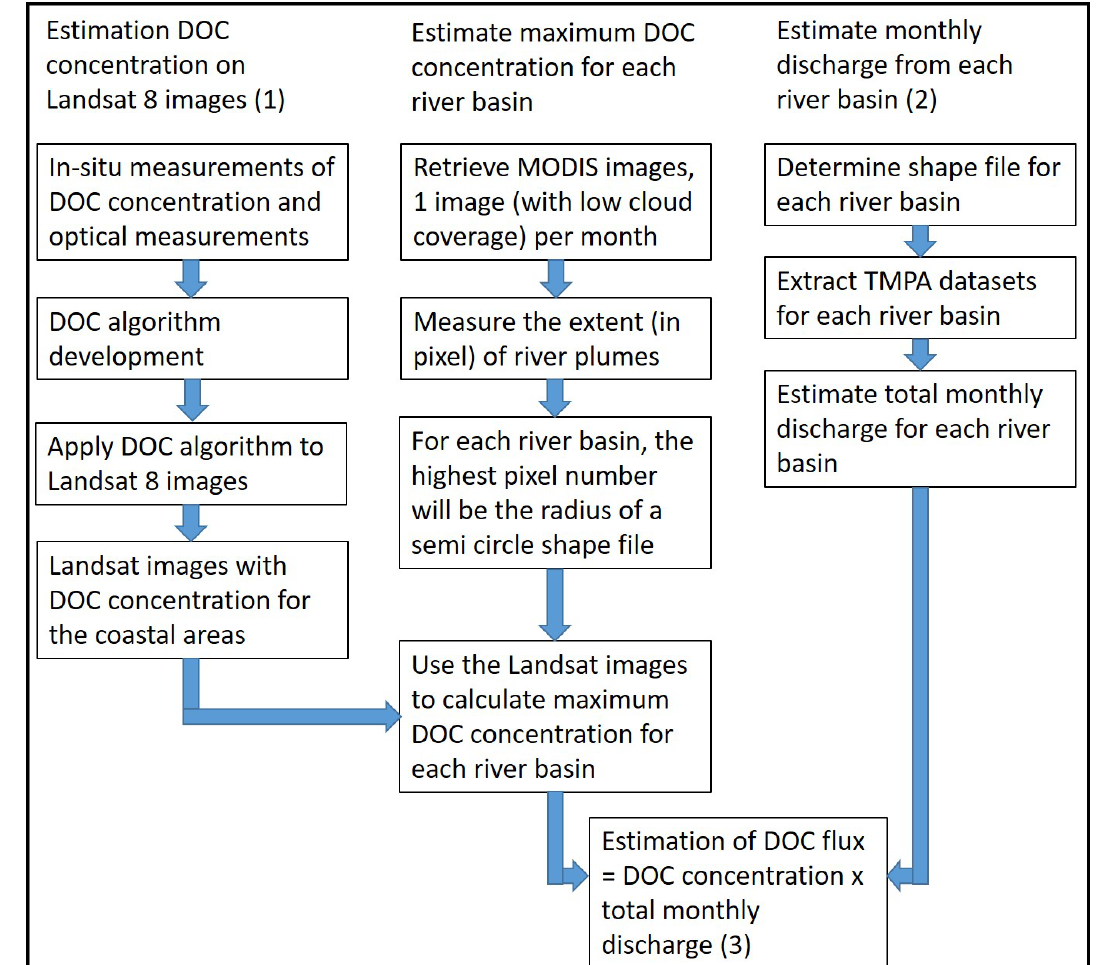
Figure 1. Flowchart summarizing method to estimate DOC concentration on Landsat-8 images, maximum DOC concentration, and monthly discharge. Lastly, maximum DOC concentration and total monthly discharge are used to calculate DOC flux from estuaries into the coastal waters. The three major steps for the method are indicated with brackets. Step (1) is to estimate DOC concentration from Landsat 8 images, step (2) is to estimate monthly discharge from each river basin and the last step (3) is to estimate DOC